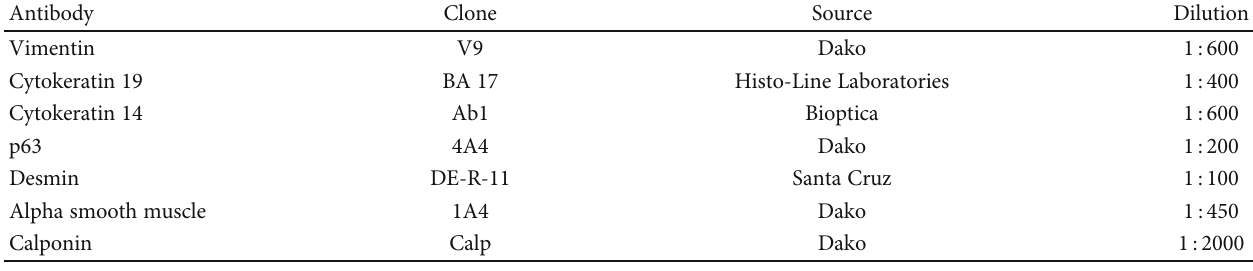
Table 1: Antibody details.